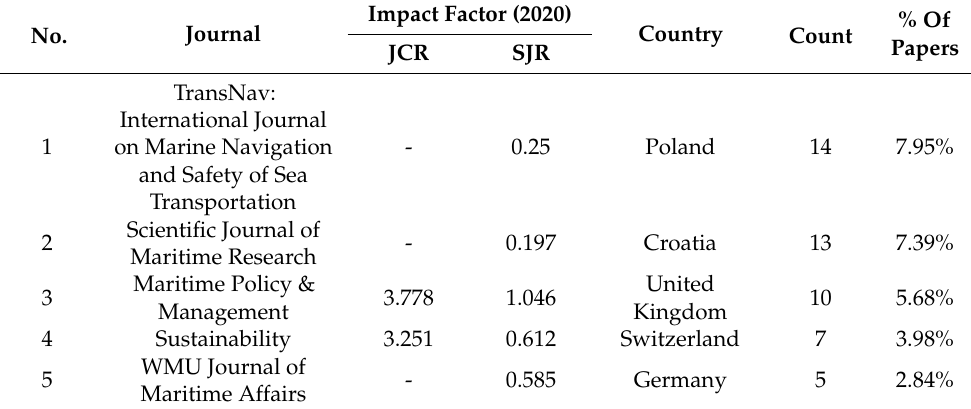
Table 6. Top five journals according to the number of published papers.